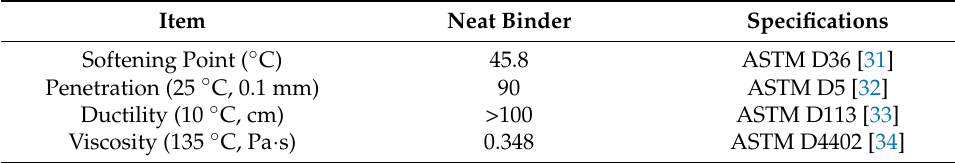
Table 2. Physical properties of neat binder.